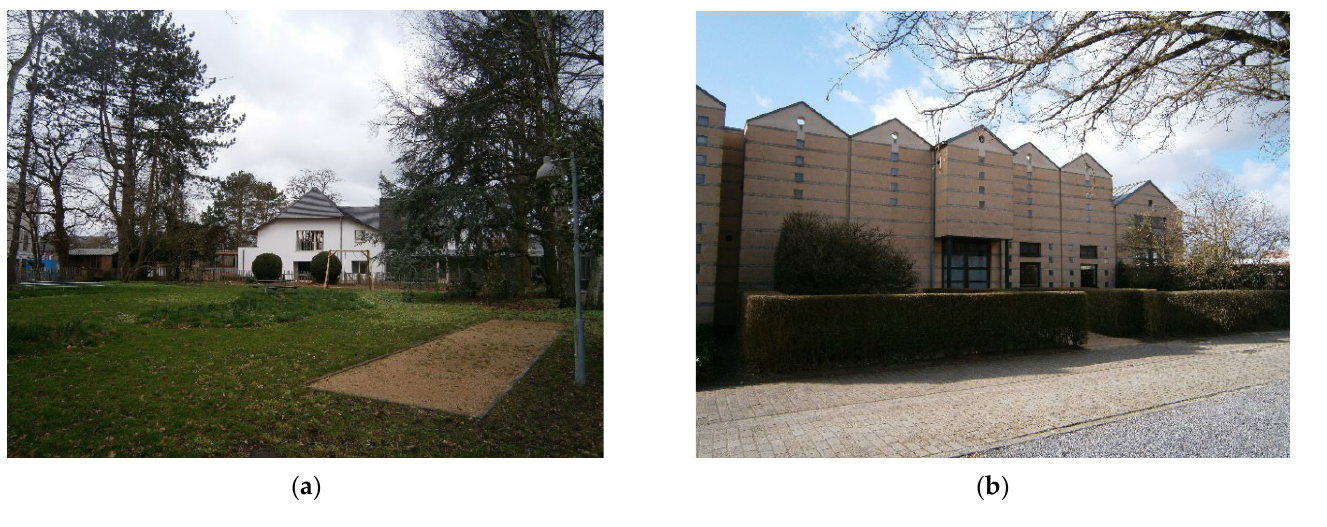
Figure 18. Main buildings of Huis Perrekes in Osterloo. Source: Own elaboration, 2020. ( a ) The backyard of the Huis Perrekes’ villa is a garden with different amenities for intergenerational use, such as swings or a petanque court. The garden offers a quiet place to walk around or stay, connected both with the indoor spaces of the villa as well as to the outdoor spaces of the village. ( b ) Huis Perrekes’ houses are completely integrated in their surroundings. The small-scale design enables normalized living and continuity within the community and urban landscape. The public space is pedestrian and bike-friendly, with slow streets and quiet areas.